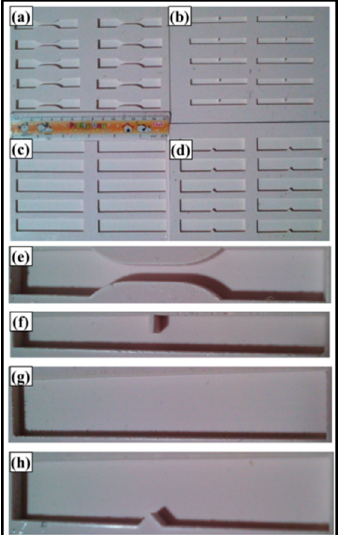
Figure 16. Dynamic mechanical properties of 0.05 wt % MLG-0.05 wt % clay-EP nanocomposites: ( a ) storage modulus; ( b ) loss modulus; ( c ) loss factor (Tan δ ); ( d ) glass transition temperature ( T g), storage modulus, loss modulus and Tan δ values corresponding to T g .